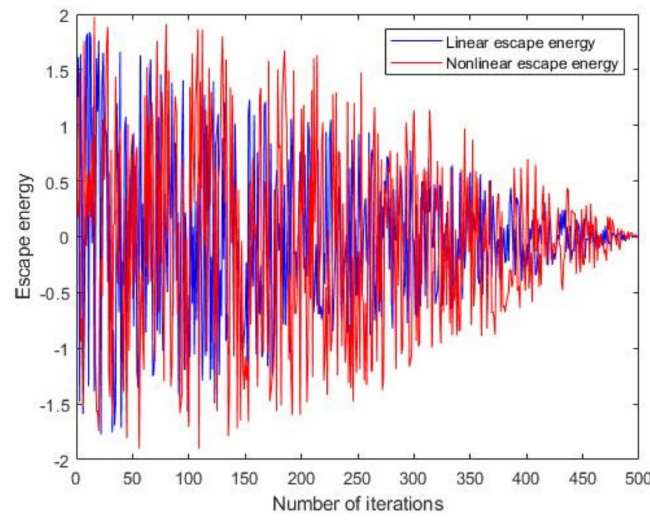
Figure 2. Escape